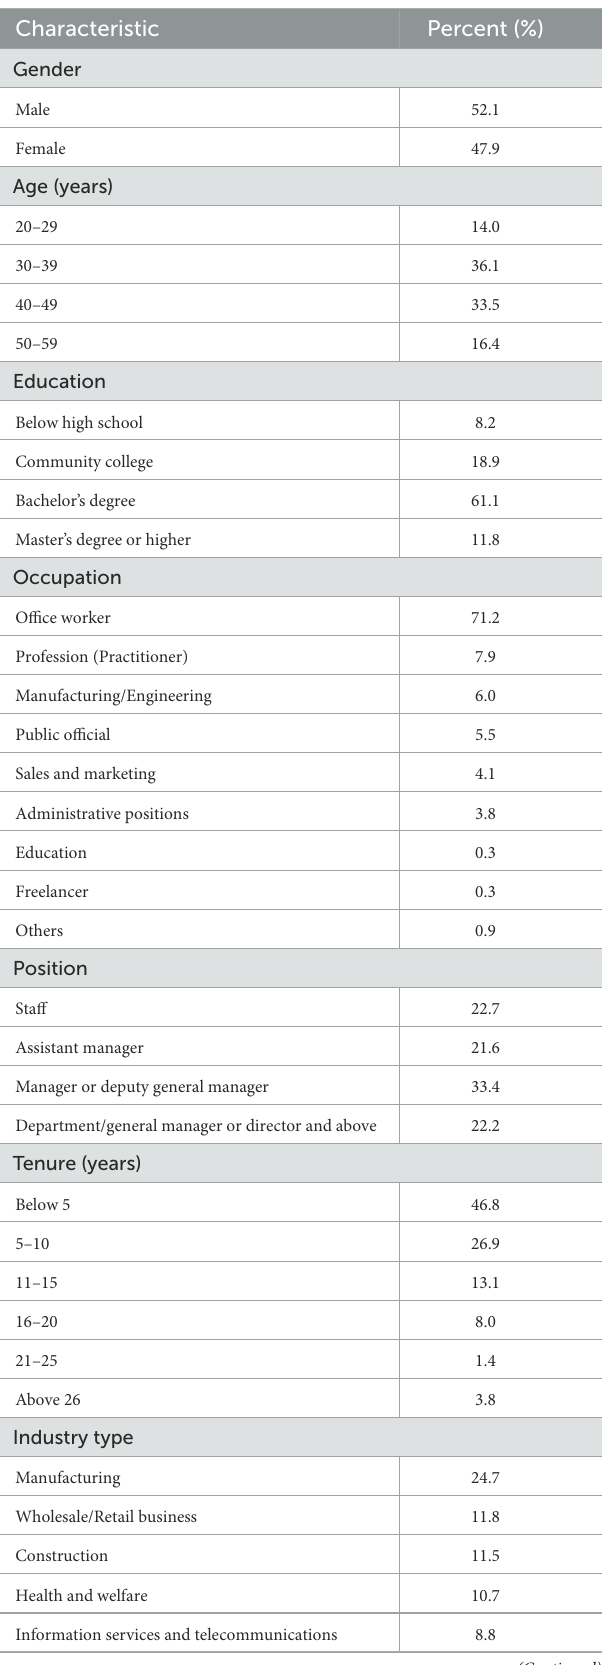
TABLE 1 Descriptive characteristics of the